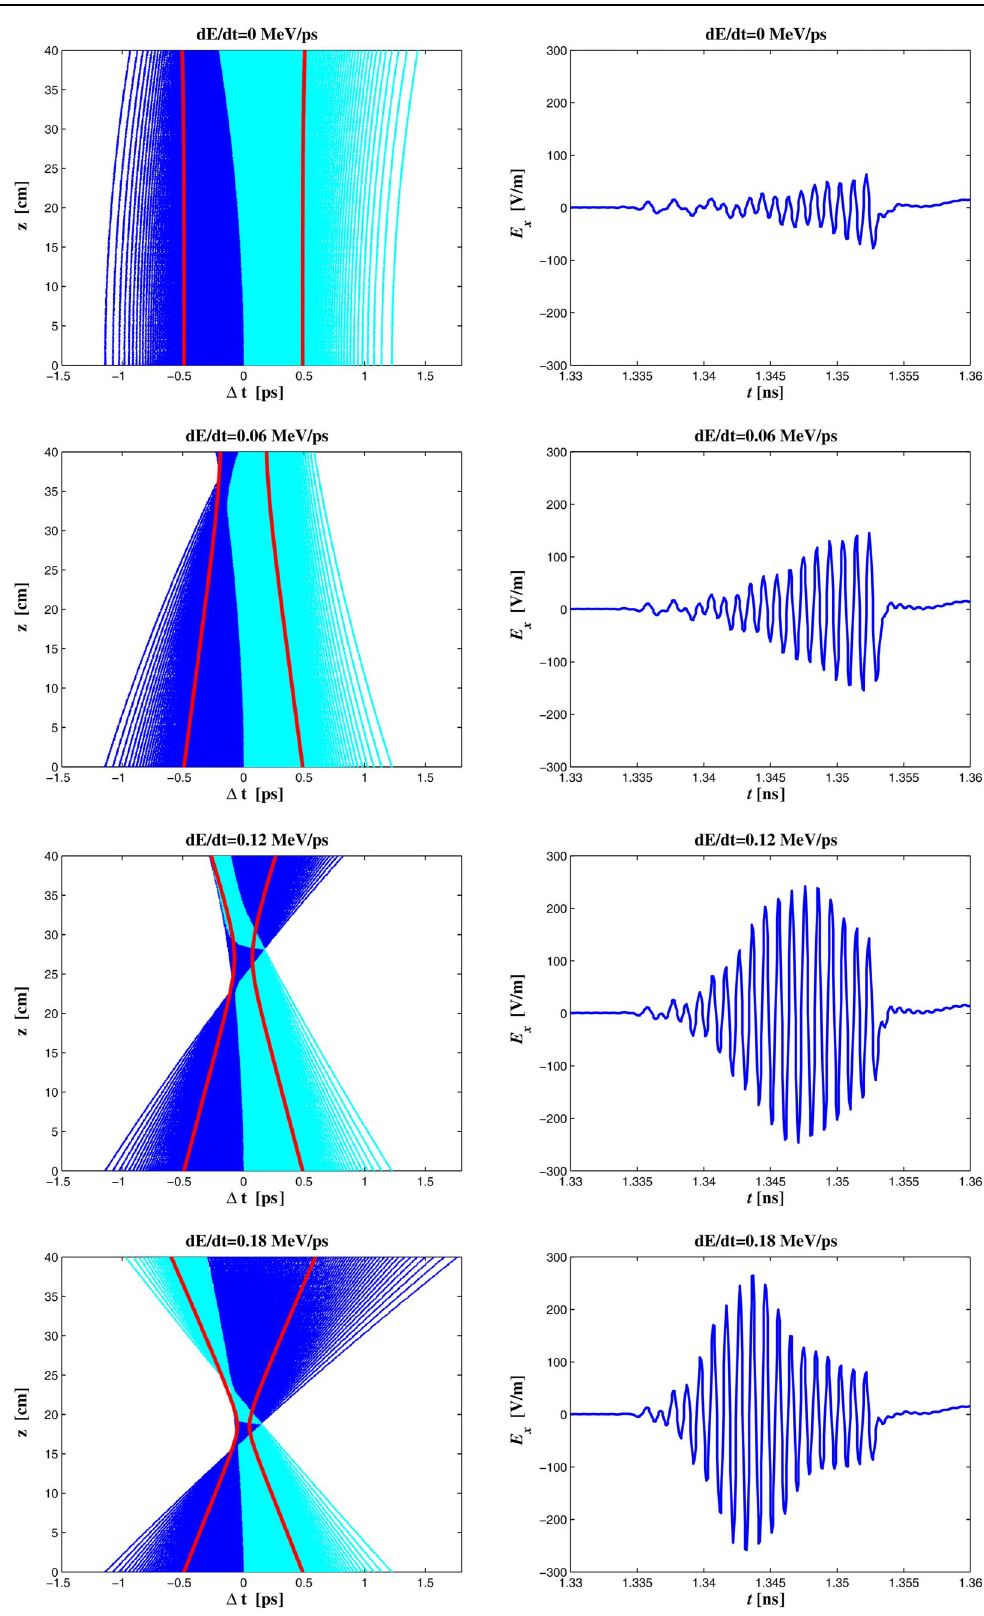
FIG. 5. (Color) Trajectories of electrons relative to the bunch center (left) and emitted time-domain electromagnetic field (right) for =dt different energy modulation rates dE k